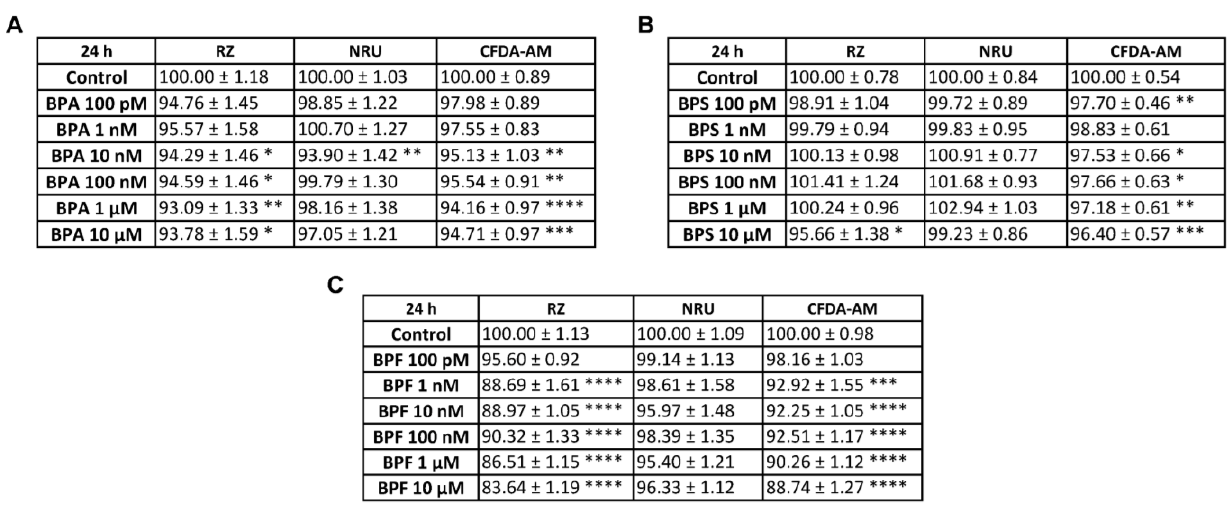
Figure 1. Viability of pancreatic α TC1-9 cells treated for 24 h with different concentrations of bisphenols. Cells were treated with a range of concentrations (100 pM–10 µ M) of ( A ) BPA, ( B ) BPS, or ( C ) BPF. Viability was evaluated with RZ, NRU, and CFDA-AM assays for each compound. Results are expressed as % of the solvent control (Control = 100%). Data are represented as mean ± SEM of ( A ) n = 4, ( B ) n = 5, and ( C ) n = 4 independent experiments. * vs. Control; * p < 0.05, ** p < 0.01, *** p < 0.001, **** p < 0.0001 by one-way ANOVA followed by Dunnett’s post hoc test or Kruskal–Wallis followed by Dunn’s post hoc test.